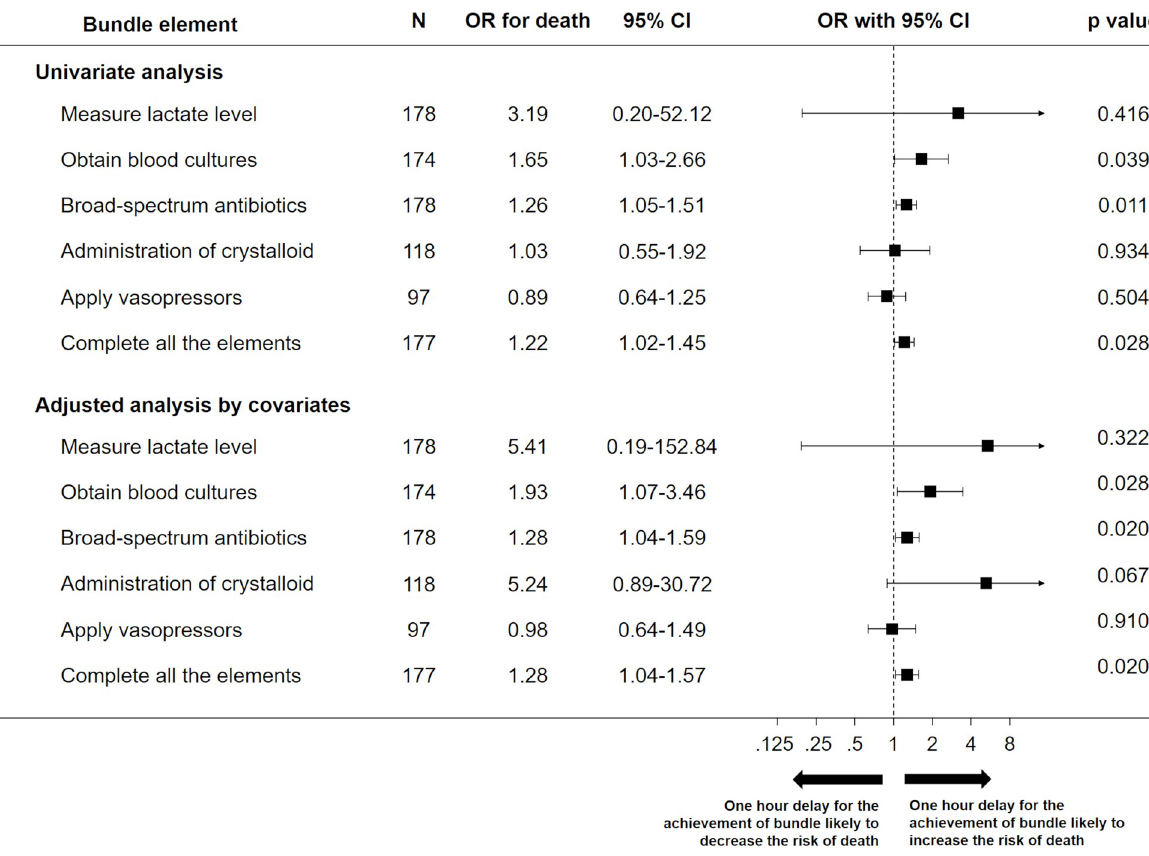
Fig 3. Association between the increase in mortality and 1-hour delay in the achievement of each bundle component. Univariate and multivariate-adjusted ORs with 95% CIs for mortality risk are represented as forest plots. Regression analyses were adjusted by including several clinically plausible and relevant confounders as covariates. OR odds ratio, CI confidence interval.